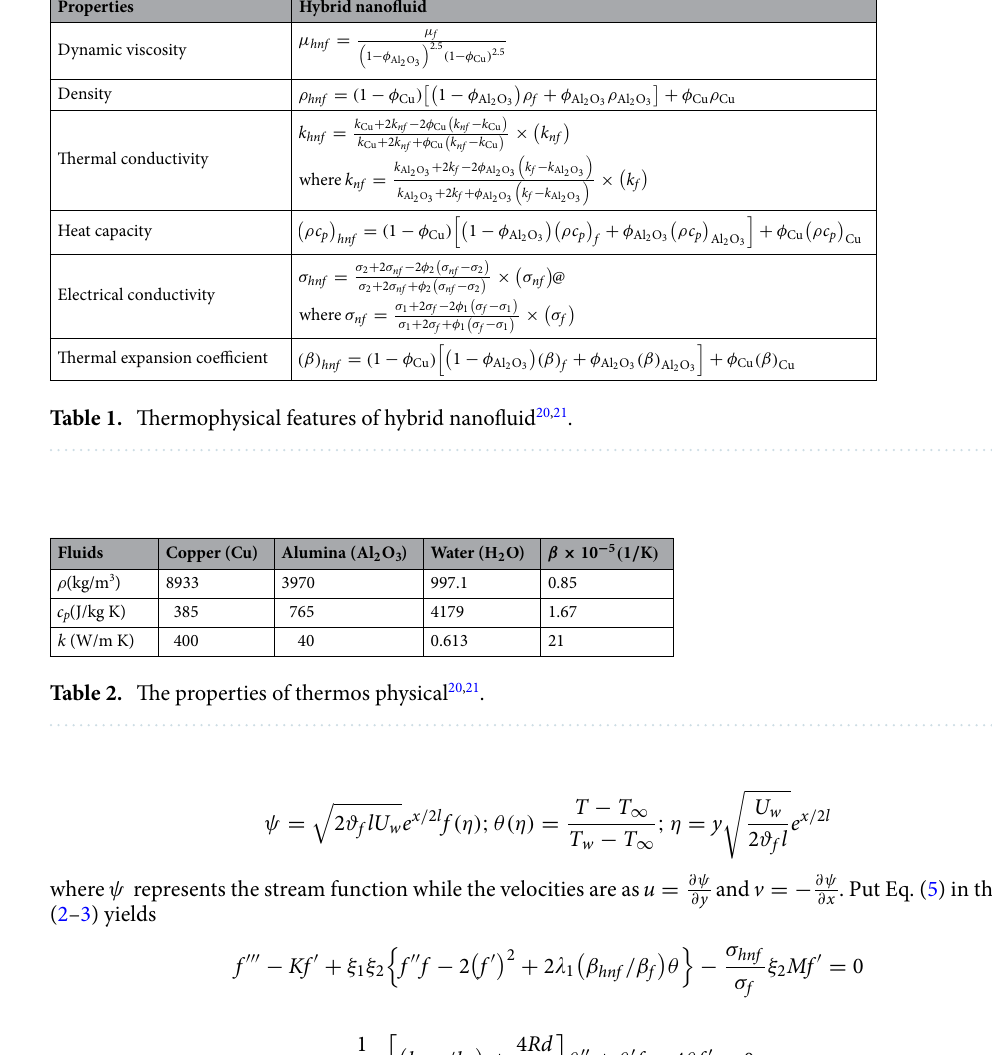
where ψ represents the stream function while the velocities are as u (2–3) yields